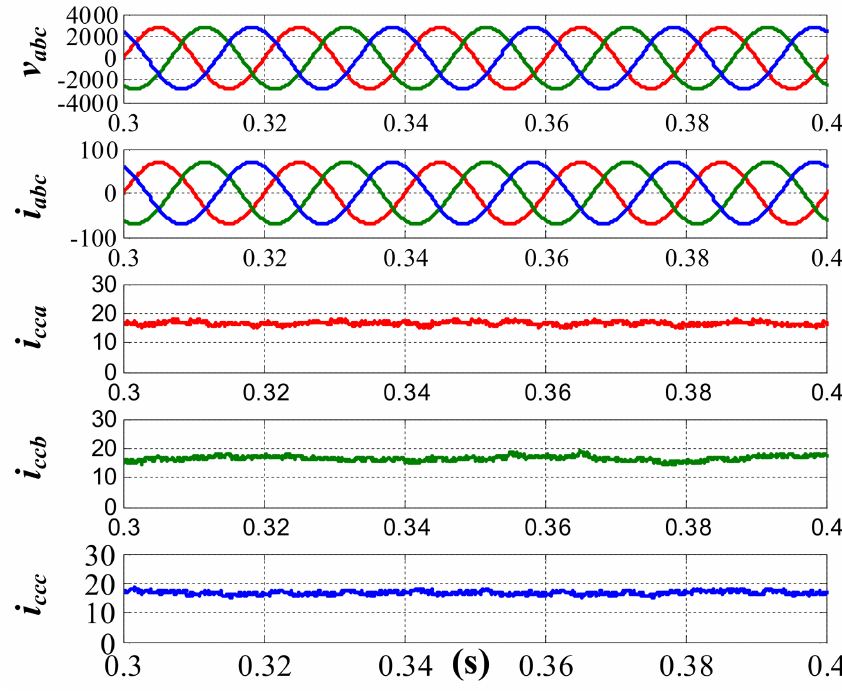
Figure 6. The normal operation